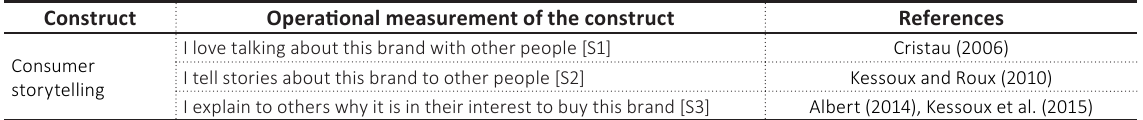
Source: Own study.